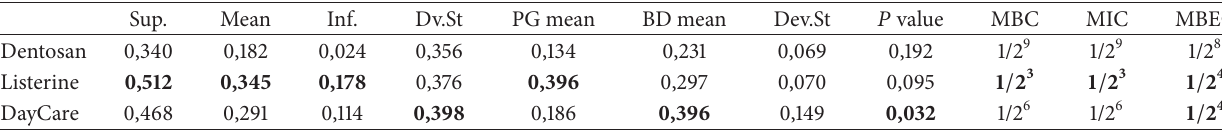
Table 1: The table is divided to three parts: in the first part the statistical analysis of total antibacterial effect by using of absolute values related to PG and PD separately is shown. In the second part there is the statistical analysis of anti-PG and anti-BD activity separately. In the third part MIC, MBC, and MEBC for each mouthwash are shown.